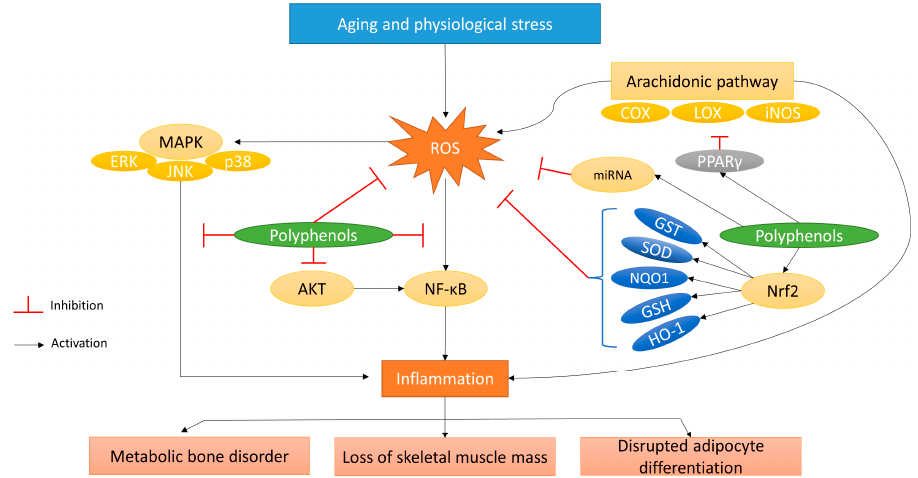
Figure 4. Overview of potential molecular targets for polyphenols’ antioxidant and anti-inflammatory activity. MAPK, mitogen-activated kinase; ERK, extracellular signal-regulated kinase; p38, p38 MAPK; AKT, protein kinase B; NF- κ B, nuclear factor-kappa β ; ROS, radical oxygen species; COX, cyclooxigenase; LOX, lipoxygenase; iNOS, inducible nitrogen oxide synthase; PPAR γ , peroxisome proliferator-activated receptor γ ; miRNA, micro ribonucleic acid; Nrf2, nuclear factor erythroid 2-related factor 2; GST, glutathione S-transferase; SOD, superoxide dismutase; NQO1, NADP(H) quinone oxidoreductase 1; GSH, glutathion; HO-1, heme oxygenase-1.